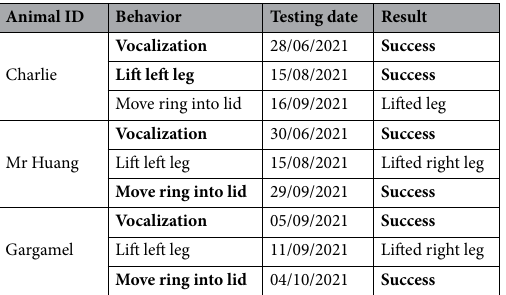
Table 1. Summary of the results of the novel behavior repeat